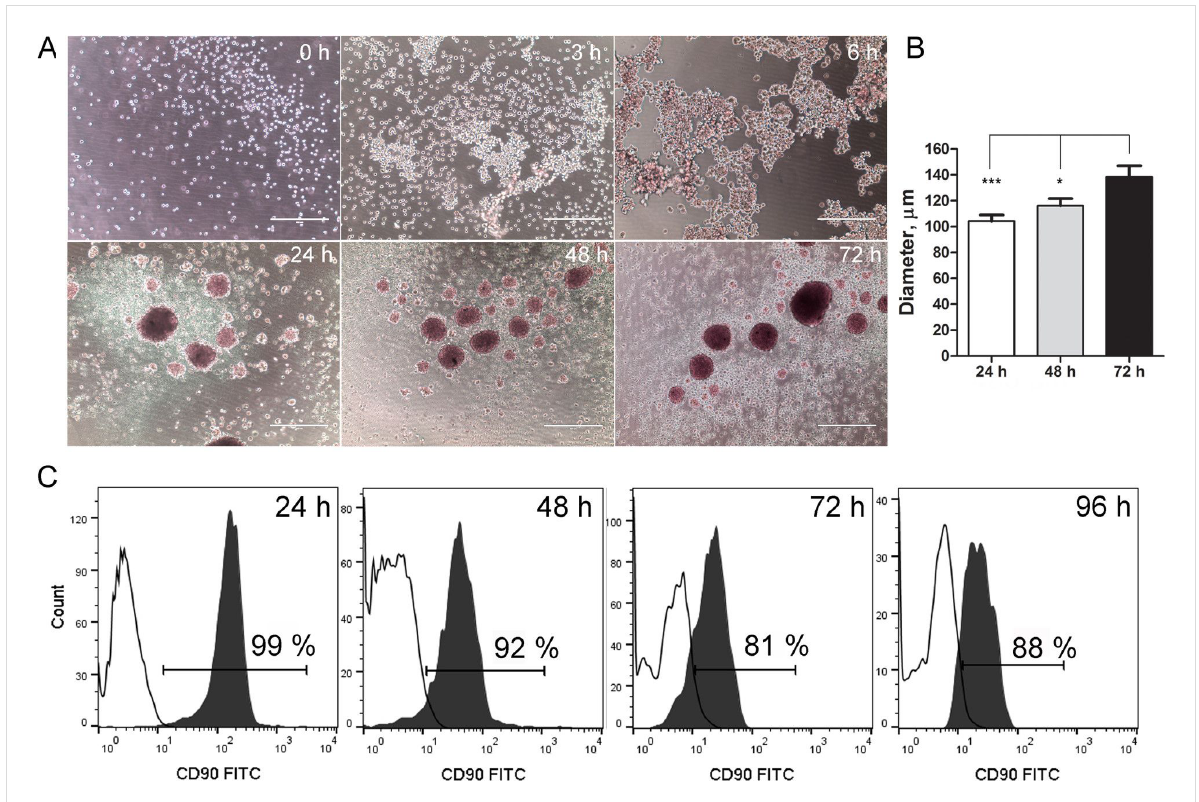
Figure 2: Characterisation of mesenchymal stem cells (MSCs) in 3D culture conditions. (A) MSC spheroid formation on polyHEMA coating. Scale bar – 400 μ m. (B) The change in the diameter of MSC spheroids in 3D culture over time. (C) The dynamics of CD90 expression in 3D cultivated MSCs. * p -value < 0.05, *** p -value < 0.001.